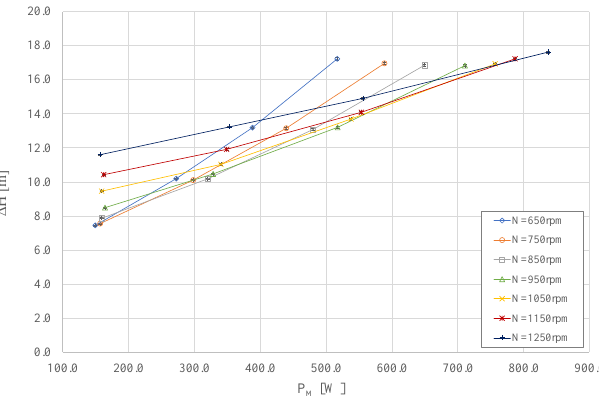
Figure 10. Curves of head drop vs. mechanical power, each referring to a specific rotational PAT speed N